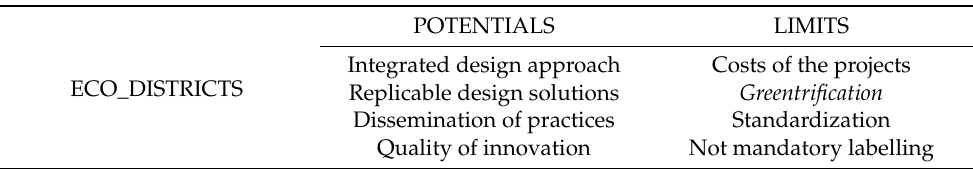
Table 18. Potentials and limits of eco-districts practices. Source: Authors’ elaboration (2022) from the analysis of the 4 case studies, data based on http://www.ecoquartiers.logement.gouv.fr and on survey/onsite visit (accessed on 19 June